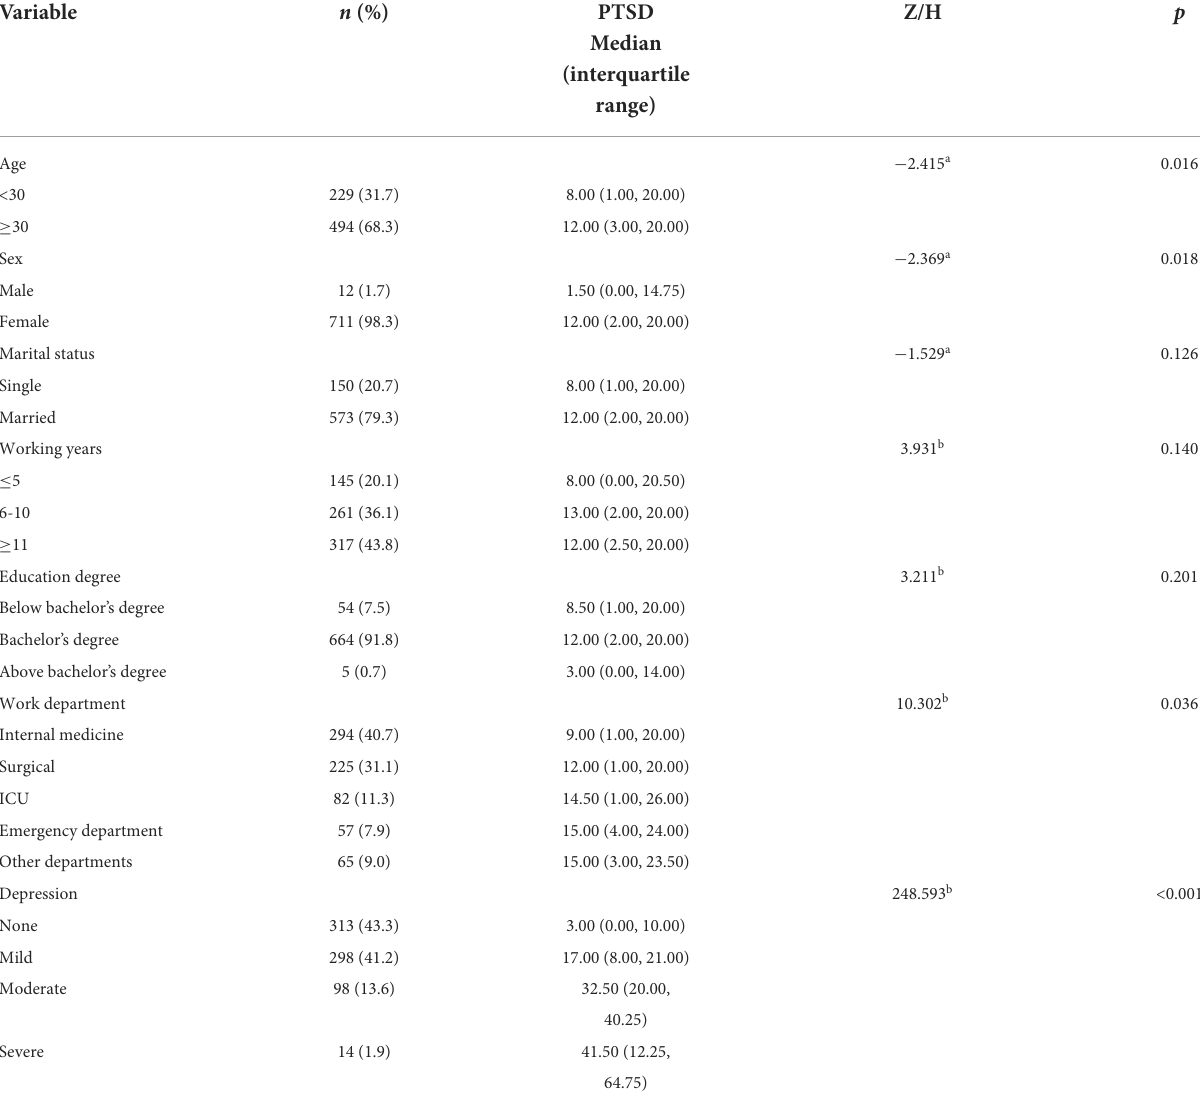
TABLE 1 Demographic characteristics of the study participants and univariate analysis for the factors related to the level of PTSD symptoms.